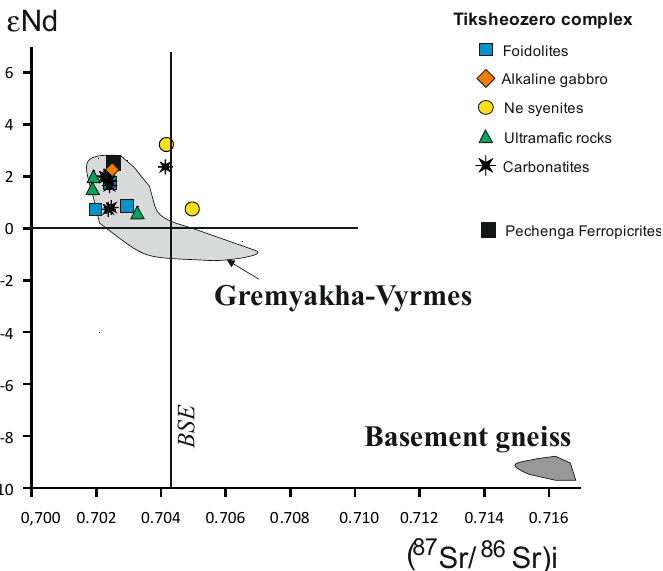
Figure 4. Sr − Nd isotope diagrams for rocks of the Tiksheozero massif. Fields for the Gremyakha − Vyrmes massif and Basement gneiss are shown after [18].